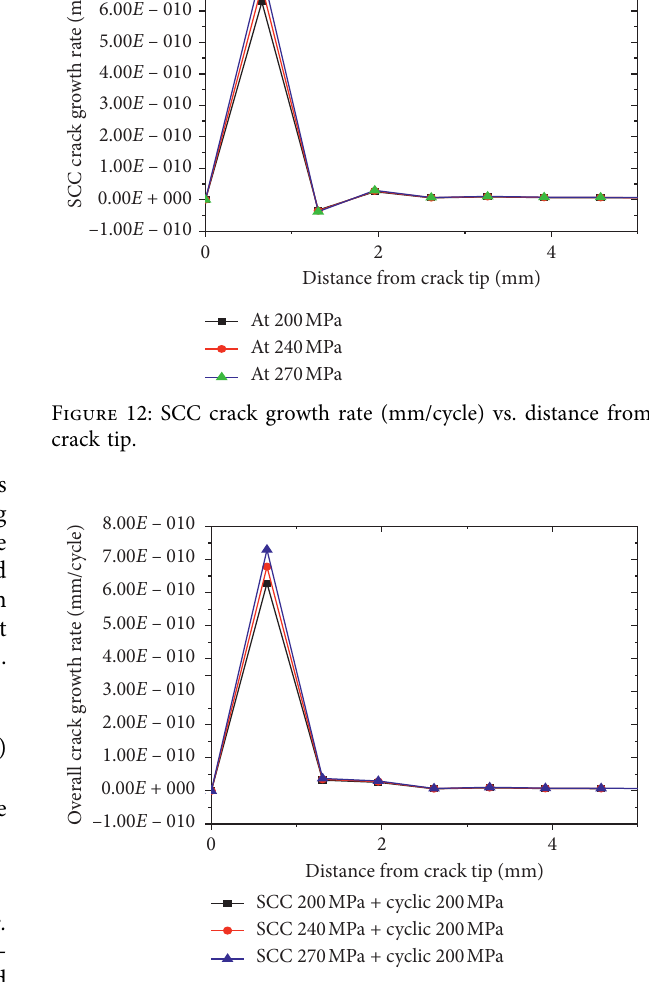
Figure 13: Overall crack growth rate vs. distance from crack